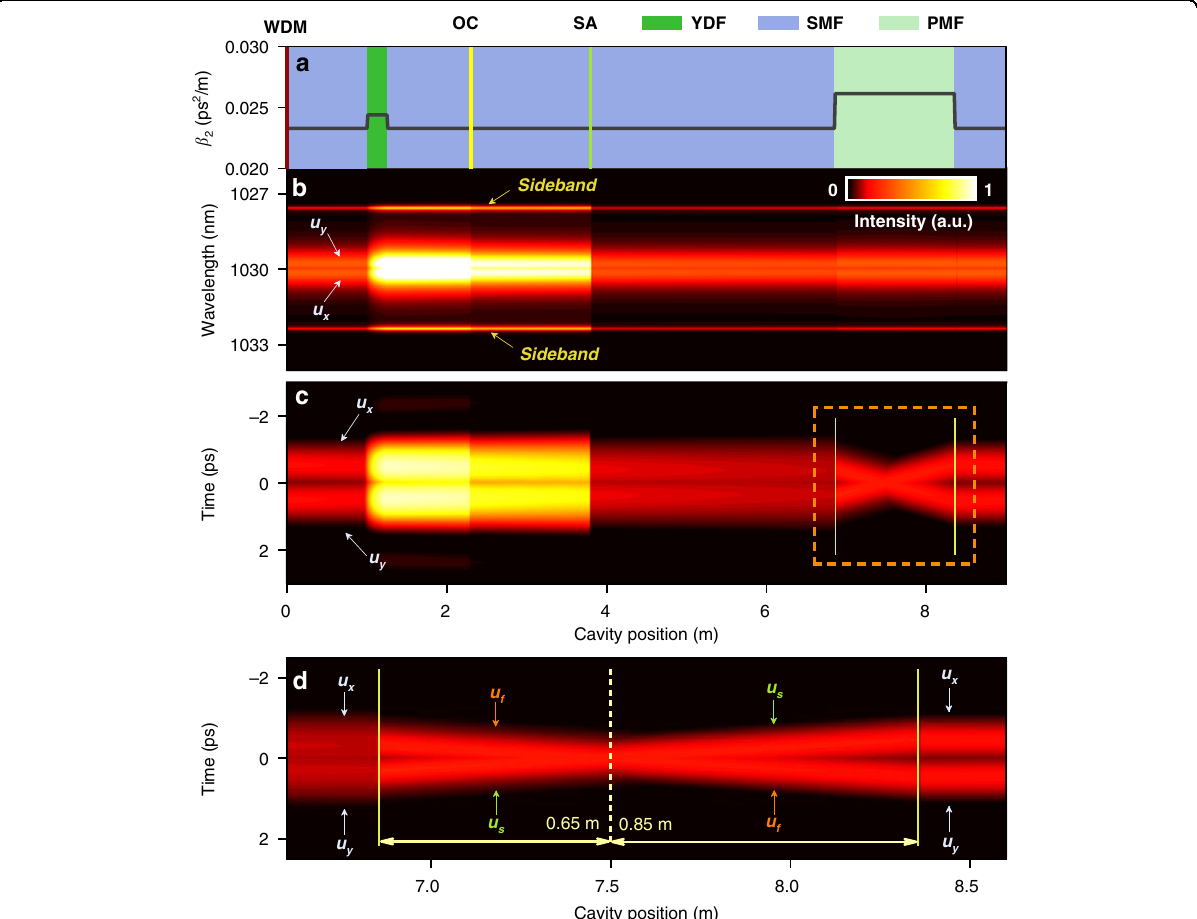
Fig. 6 Intracavity evolution of BMS at θ = 0.25 π . a Cavity position versus fi ber components and dispersion parameters. b Spectral evolutions of u x and u y components. c Temporal evolutions of u x and u y components. d Close-up of the temporal evolution around the PMF region. WDM wavelength division multiplexer, OC optical